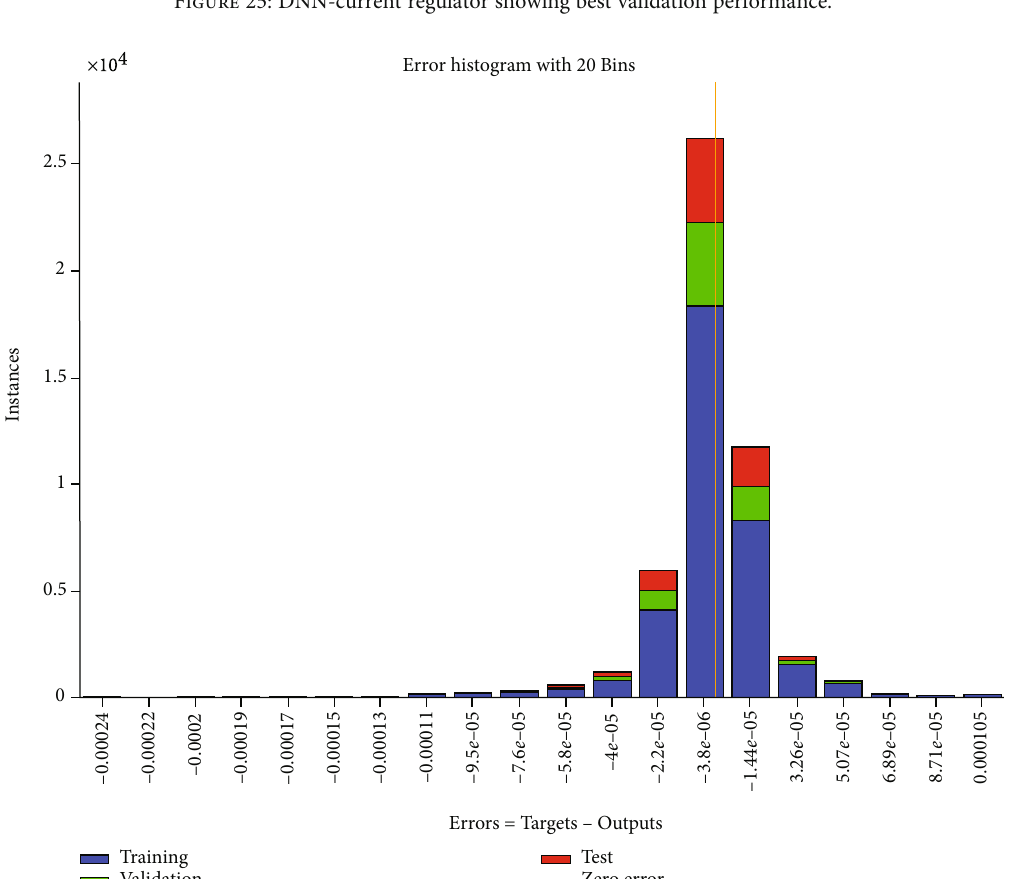
Figure 26: Error histogram of a DNN-based current